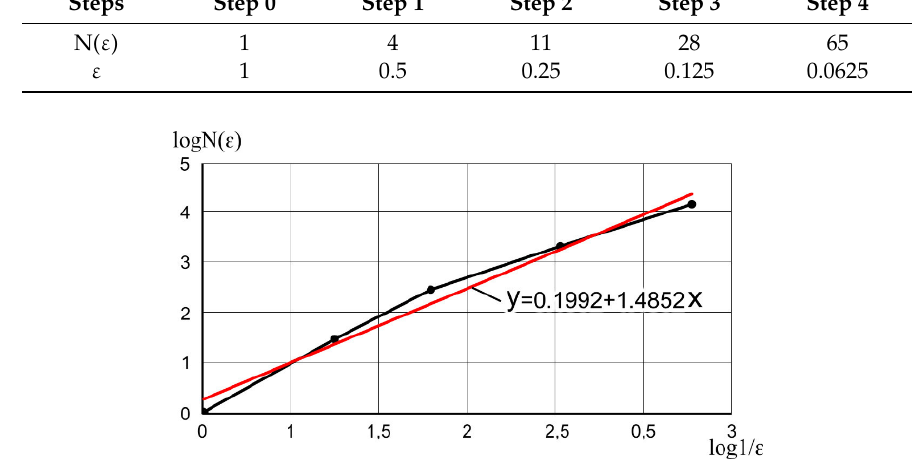
Figure 6. The regression line to estimate the fractal dimension. Table 1. The change of N( ) versus different values of for the example in Figure 5.